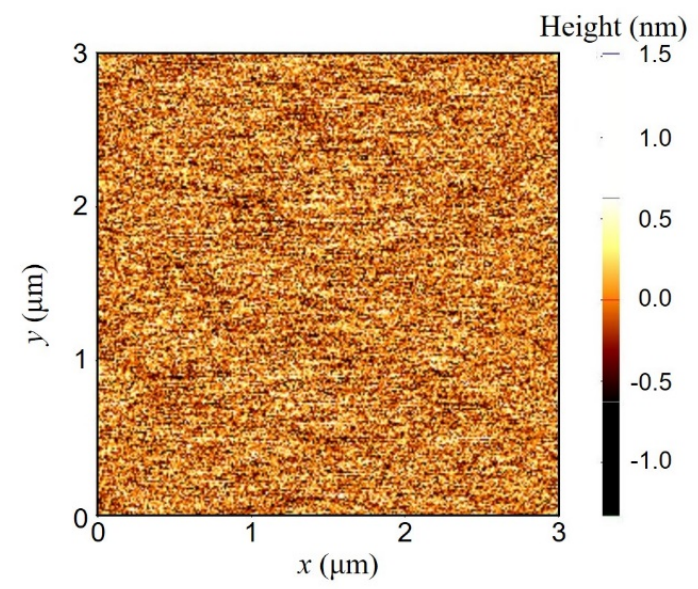
Figure 5. Atomic force micrograph of 200 nm thick α -Fe 2 O 3 film.